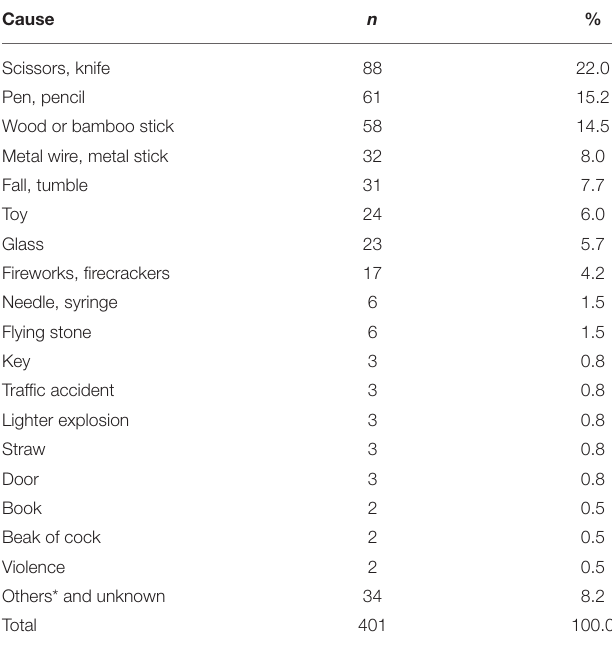
TABLE 1 | Causes of pediatric open globe injuries.